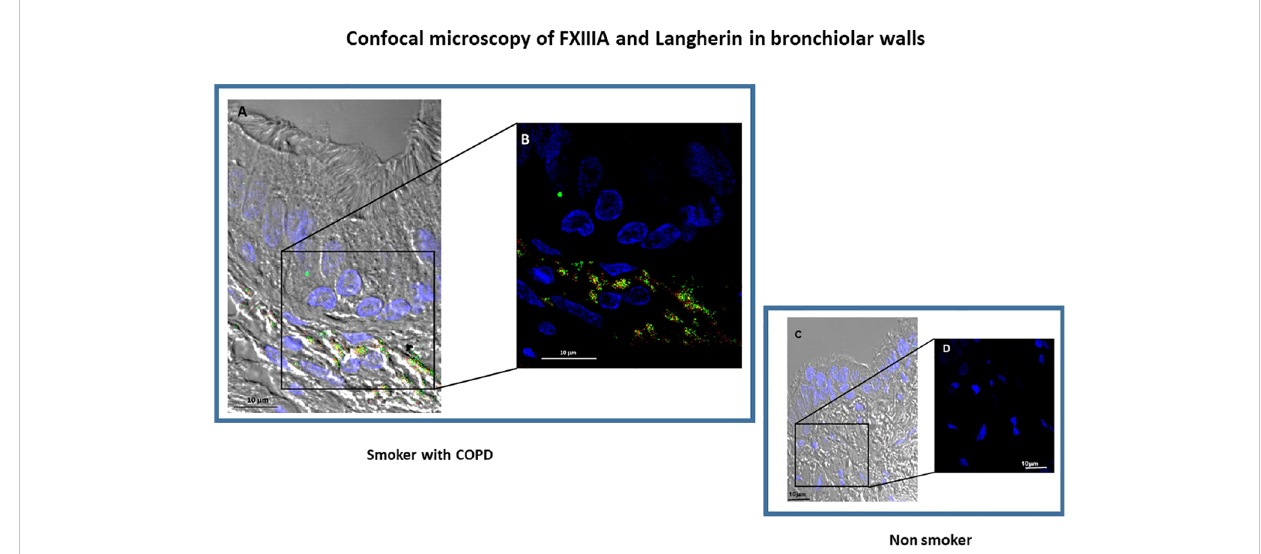
FIGURE 3 Confocal microscopy of FXIIIA+ and Langherin+cells (dendritic cells, DC-1). Small airway morphology showing epithelium and submucosa by differential interference contrast (DIC) in a COPD subject (A, B) and in a non-smoking subject (C, D) . The DC-1 cells in the airway submucosa can be identi fi ed by the double expression of Langerin (red) and FXIIIA (green). (B) shows an enlarged detail from (A) con fi rming the co-expression of FXIIIA (green) and Langerin (red) in the COPD subject, that is not present in the non-smoking subject (C, D) . Nuclei were stained with DRAQ5 (blue), FXIIIA (green), Langerin (red). Scale bars= 10 m